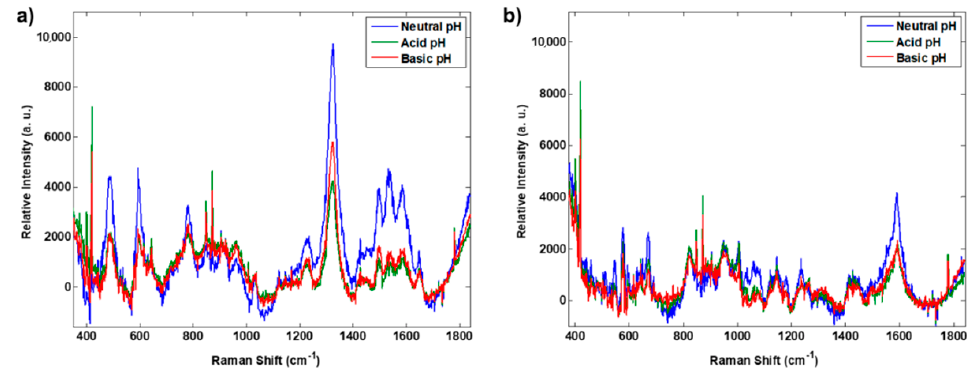
Figure 6. SERS spectra with pH variation for ( a ) SMX and ( b ) TMP.